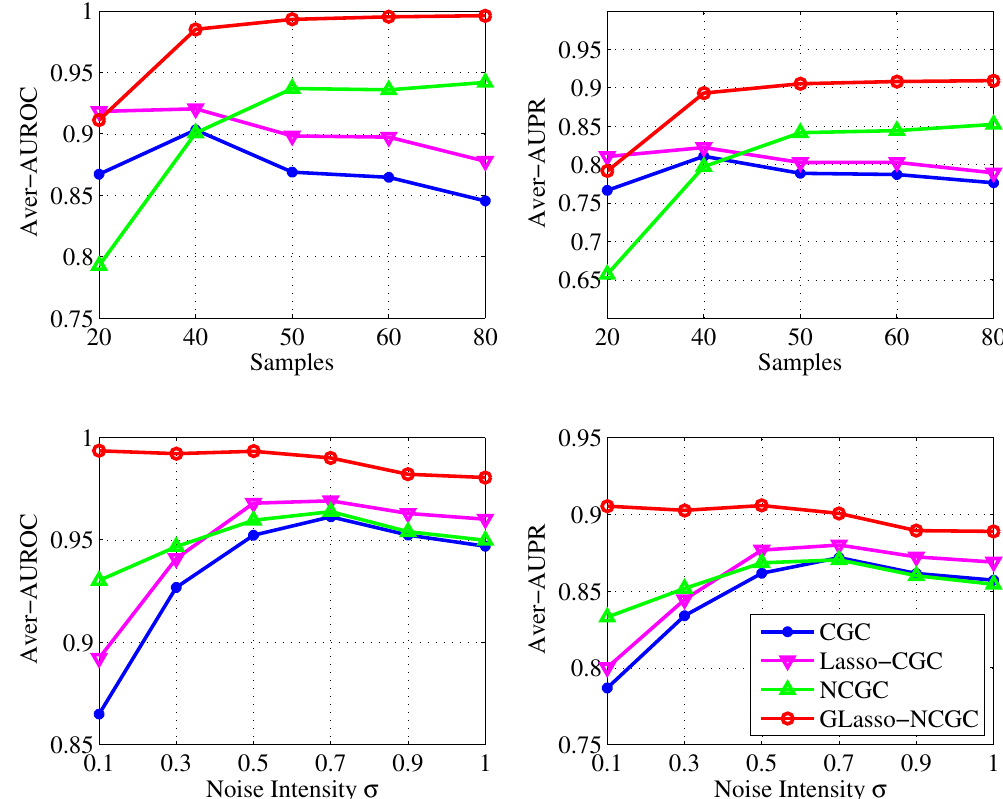
Figure 7. Simulation of BRN. Average AUROC and Average AUPR acrossing samples (20~80), noise intensities σ (0.1~1) respectively. The values of points in these figures are computed by averaging over 100 independent